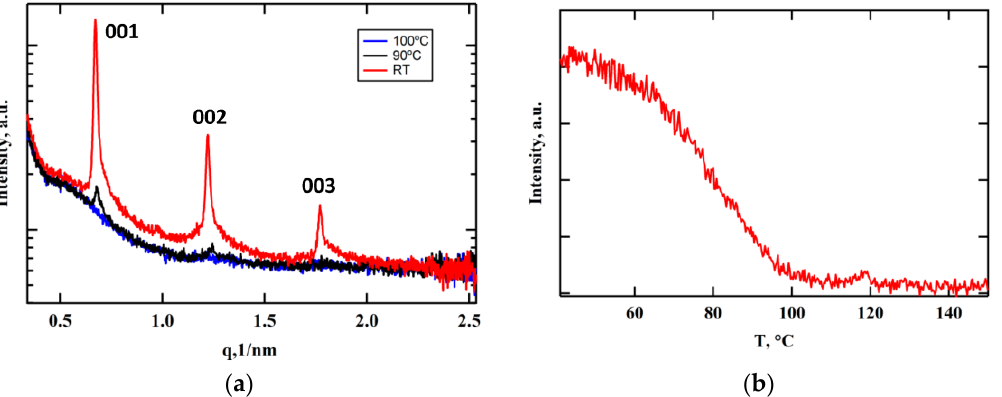
Figure 3. X-ray diffraction patterns measured at different temperatures ( a ) and temperature de- pendence of the first diffraction order (001) intensity ( b ) for the mixture. The measurements were performed under slow cooling (1 °C/min).